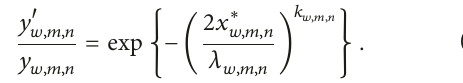
Figure 2: Desired range with and without the preferred deployment of charging